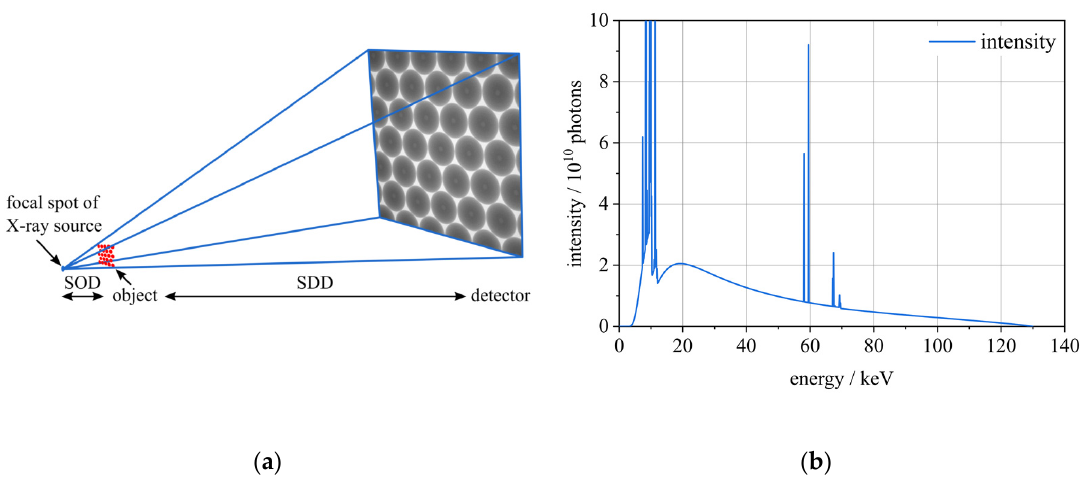
Figure 1. Scheme for measuring the contrast to noise ratio (CNR): the position of the line profile for the CNR measurement ( a ) and representation of the corresponding profile with and without noise to measure the CNR ( b ).